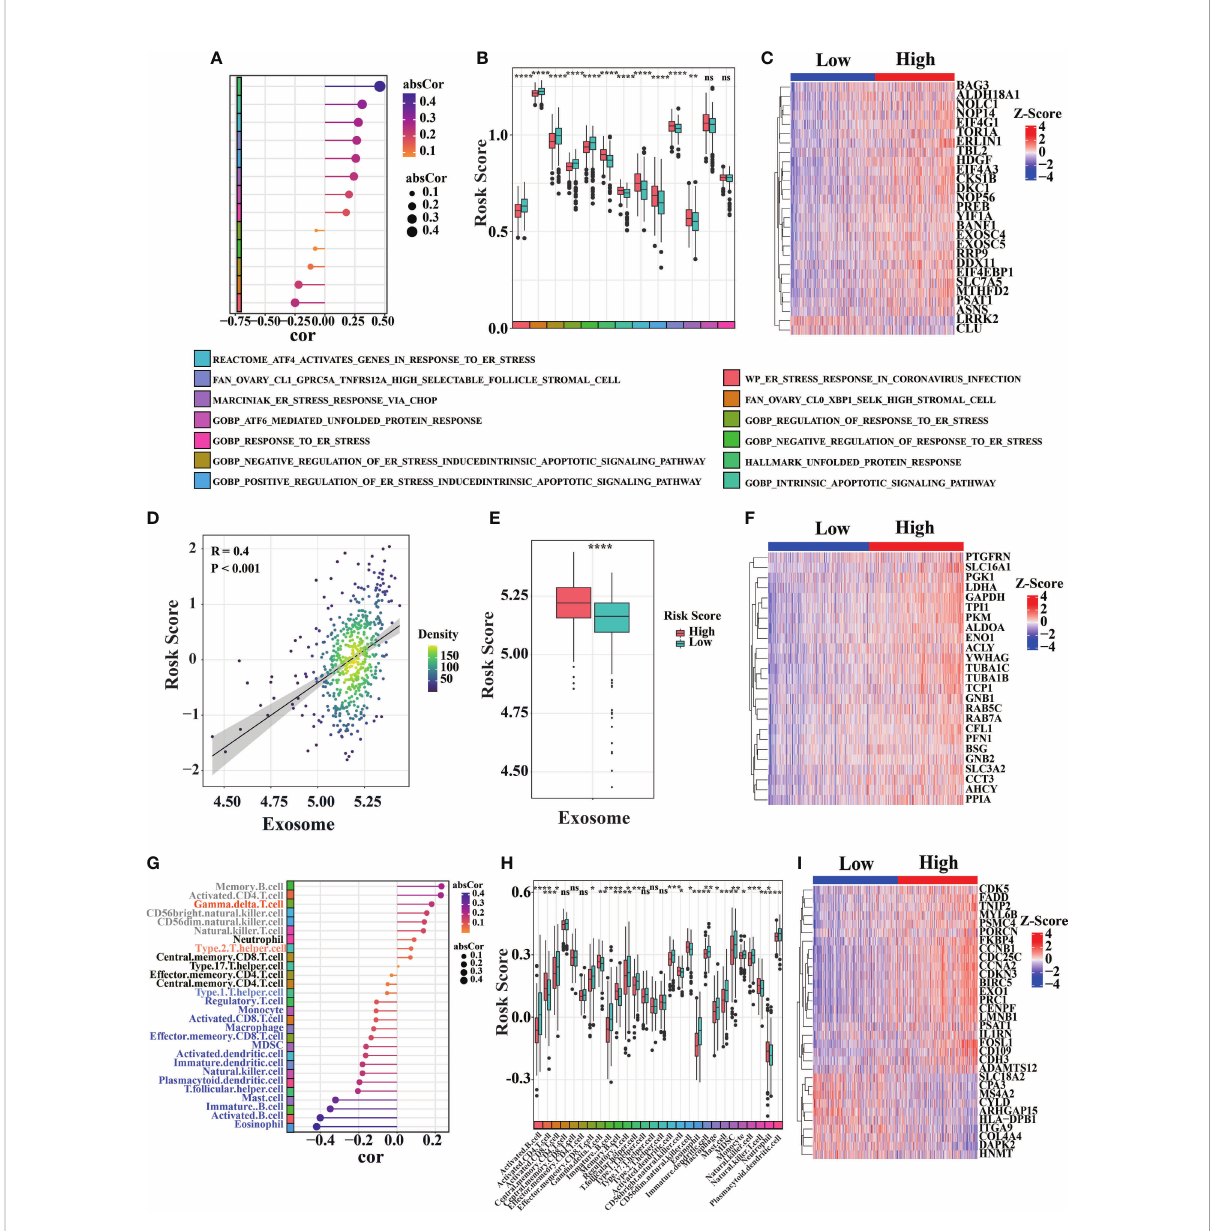
FIGURE 5 Bioprocess analysis base on prognosis signature. (A) Correlation diagram between risk score and ER stress-related gene set score (ssGSEA) in primary LUAD sample from TCGA cohort (n = 520). (B) Analyze ER stress-related gene set scores (ssGSEA) differences between high-risk and low-risk of primary LUAD samples in TCGA cohort. (C) Heat map of ER stress-related genes expression in LUAD patients from TCGA database. (D – F) The correlation between risk score and exosome associated score were analyzed similarly to the above ER stress pathway in TCGA cohort. (G – I) The correlation between risk score and different immune cell in fi ltration were analyzed similarly to the above ER stress pathway in TCGA cohort (the color block on the left represents different types of immune cells, the position indicates the magnitude of correlation coef fi cient, “ ns ” was non-signi fi cant, *P< 0.05, **P< 0.01, ***P< 0.001, ****P<